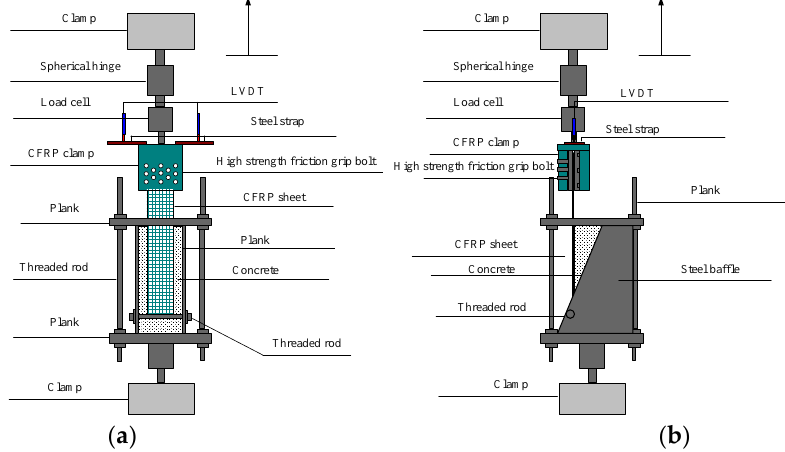
Figure 6. Schematic diagram of the devices for single shear tests: ( a ) front view; and ( b ) side view.